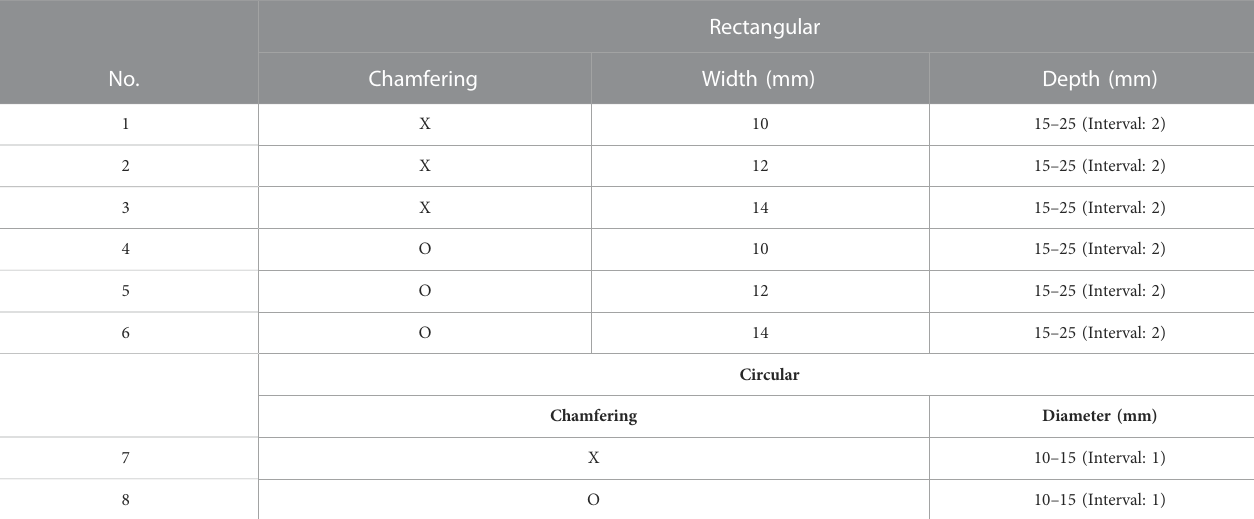
TABLE 3 Scenarios associated with orbital wall removal.